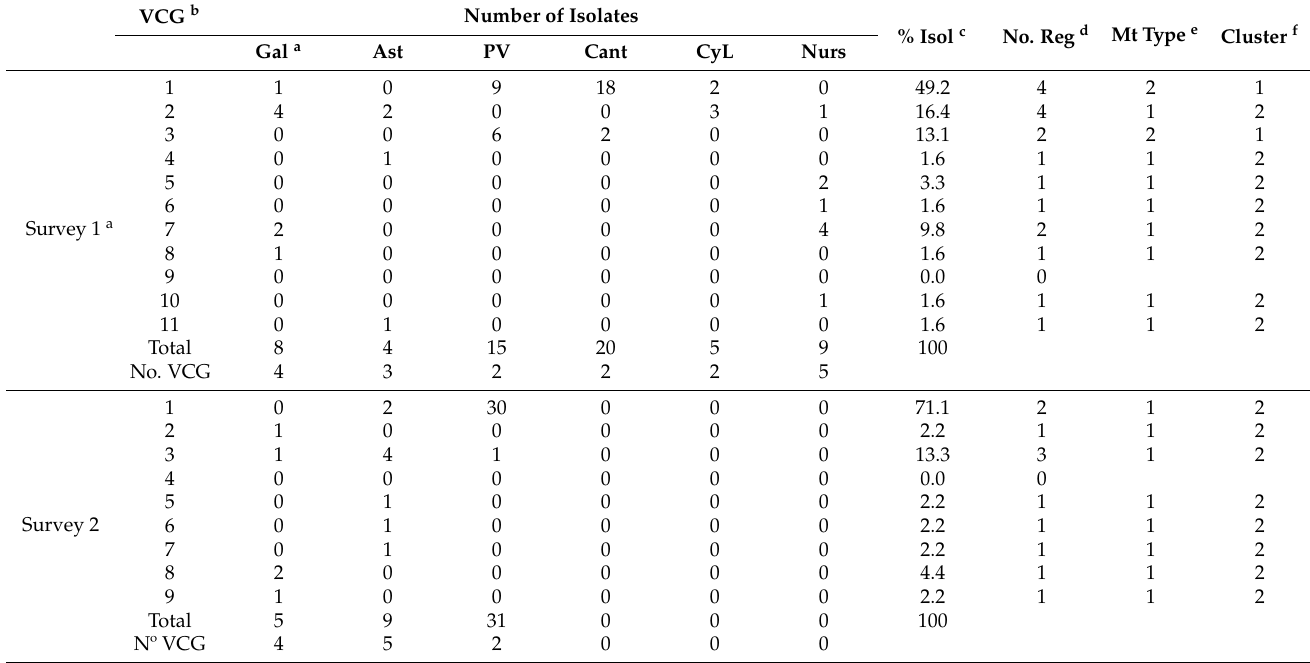
Table 8. Vegetative compatibility group and mating type in the Spanish population of Fusarium circinatum defined in a temporal scale and by geographic